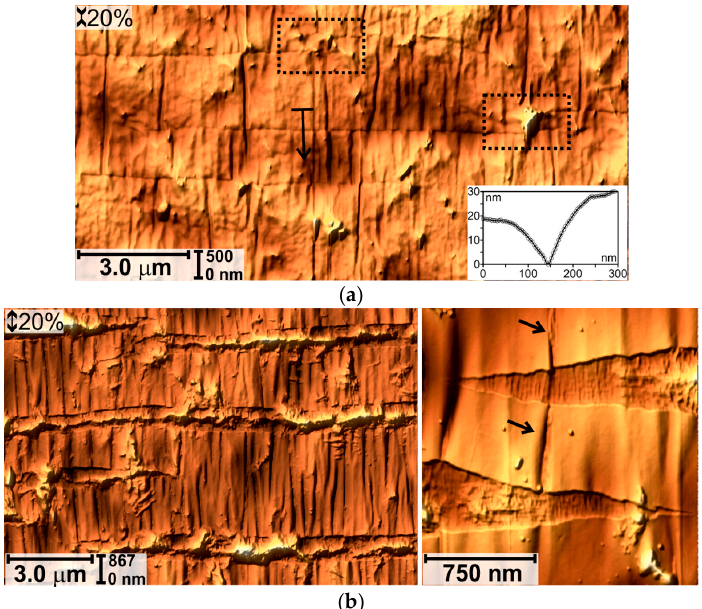
Figure 7. AFM images of PU after the PIII 1-17 and fatigue loading to 20% in the unloaded ( a ) and stretched ( b ) states. Surface inhomogeneities stop propagation of cracks (marked by box in ( a )). Stiff edges of the broken layer dissect polymer in the cracks, clots of it are visible above the cracks ( b ). The broken longitudinal fold makred in ( b ) by arrows.